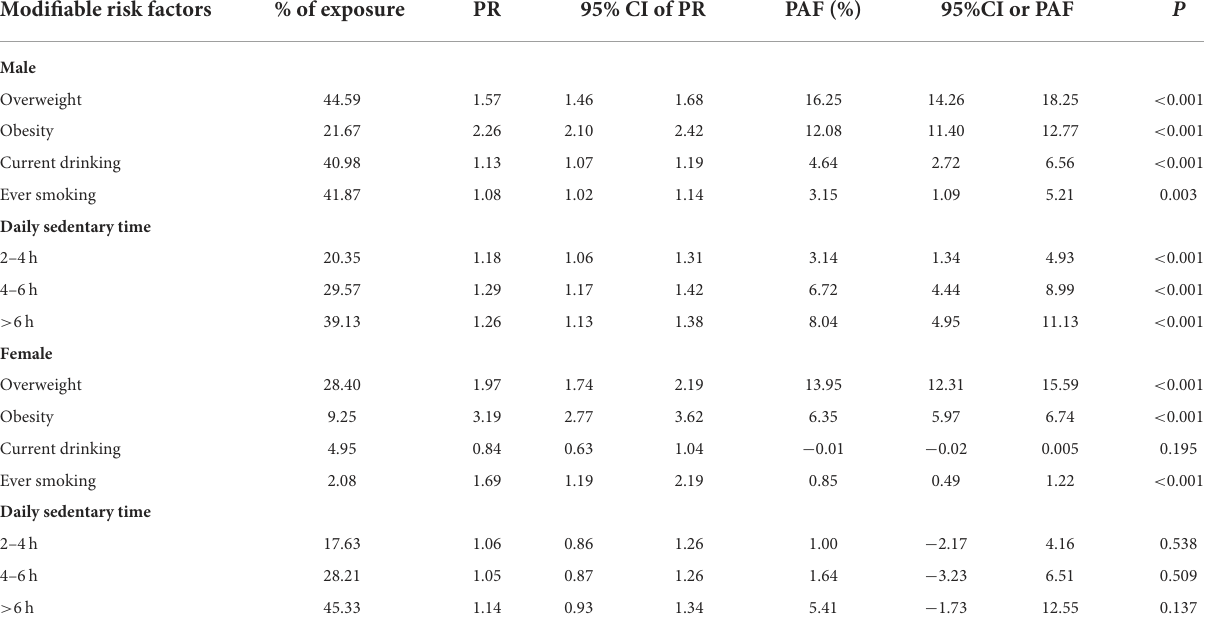
TABLE 4 The prevalence ratio, population attributable fraction of modifiable risk factors for hyperuricemia, stratified by